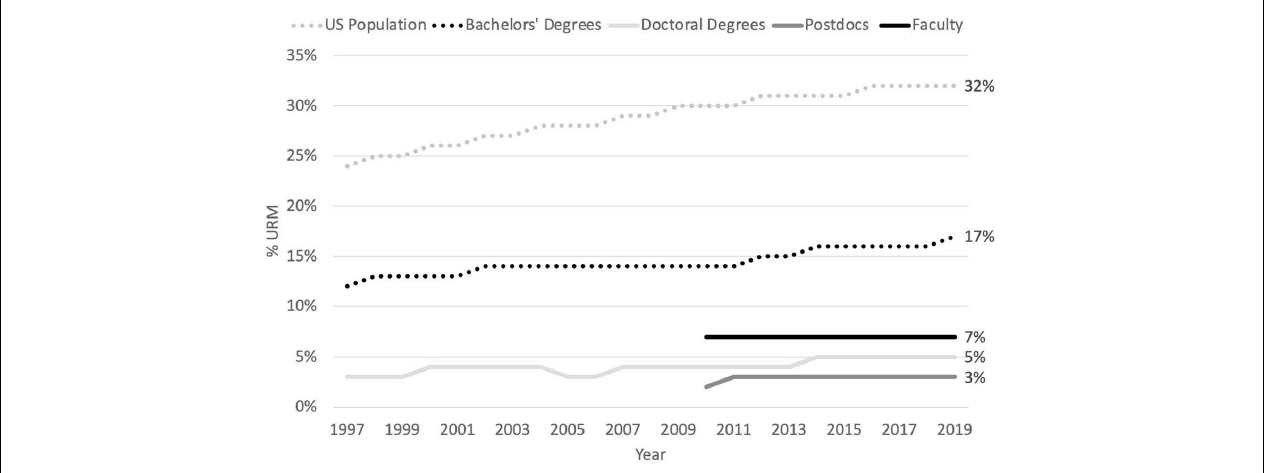
FIGURE 1 | Trends in URM representation in MPCES, 2010–2019. URM (Hispanic; Black or African American, non-Hispanic; American Indian or Alaska Native, non-Hispanic; and where the data permits Native Hawaiian or Other Pacific Islander, non-Hispanic) representation in the United States has increased from 30% in 2010 to 32% in 2019. Over that same period the general population trends have been mirrored by URM representation among all MPCES bachelor degrees (including Temporary visa holders) which has increased from 14% to 17%. URM representation among MPCES doctoral degrees (including Temporary visa holders), and among MPCES postdocs (including Temporary visa holders), has increased only slightly from 4 to 5%, and 2 to 3%, respectively. URM representation among MPCES faculty has held steady at 7% over this period (CDC, 2021; NCES,